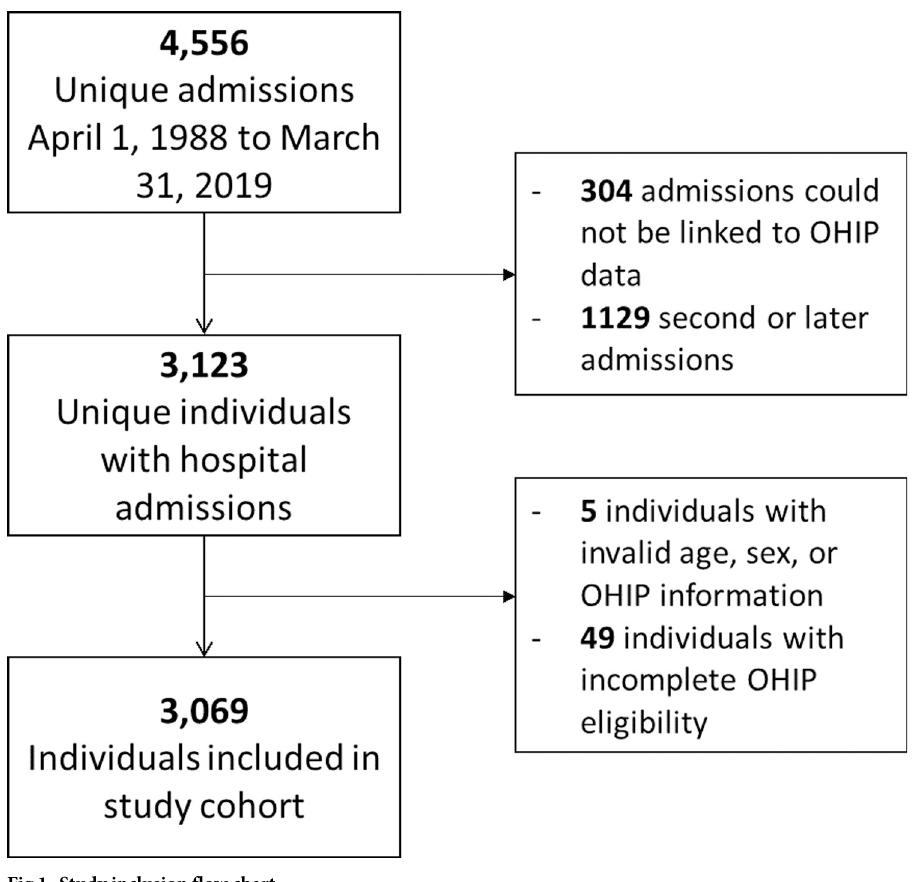
Fig 1. Study inclusion flow chart.